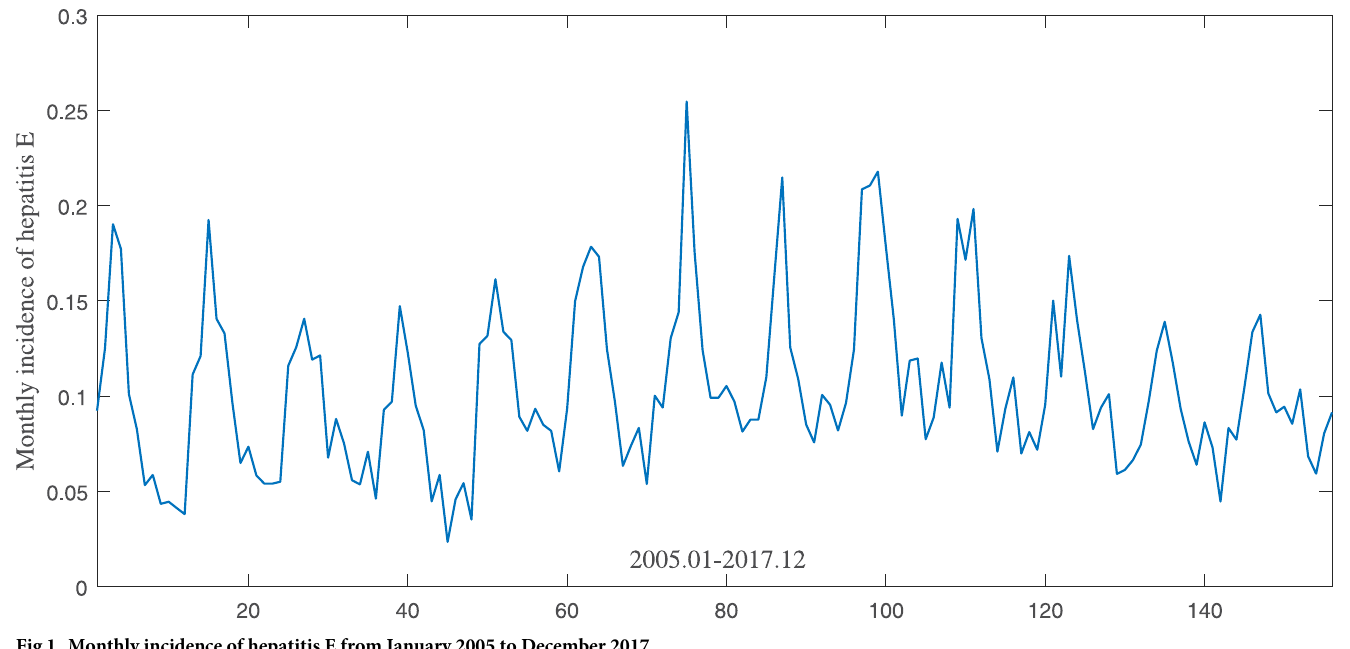
Fig 1. Monthly incidence of hepatitis E from January 2005 to December 2017.